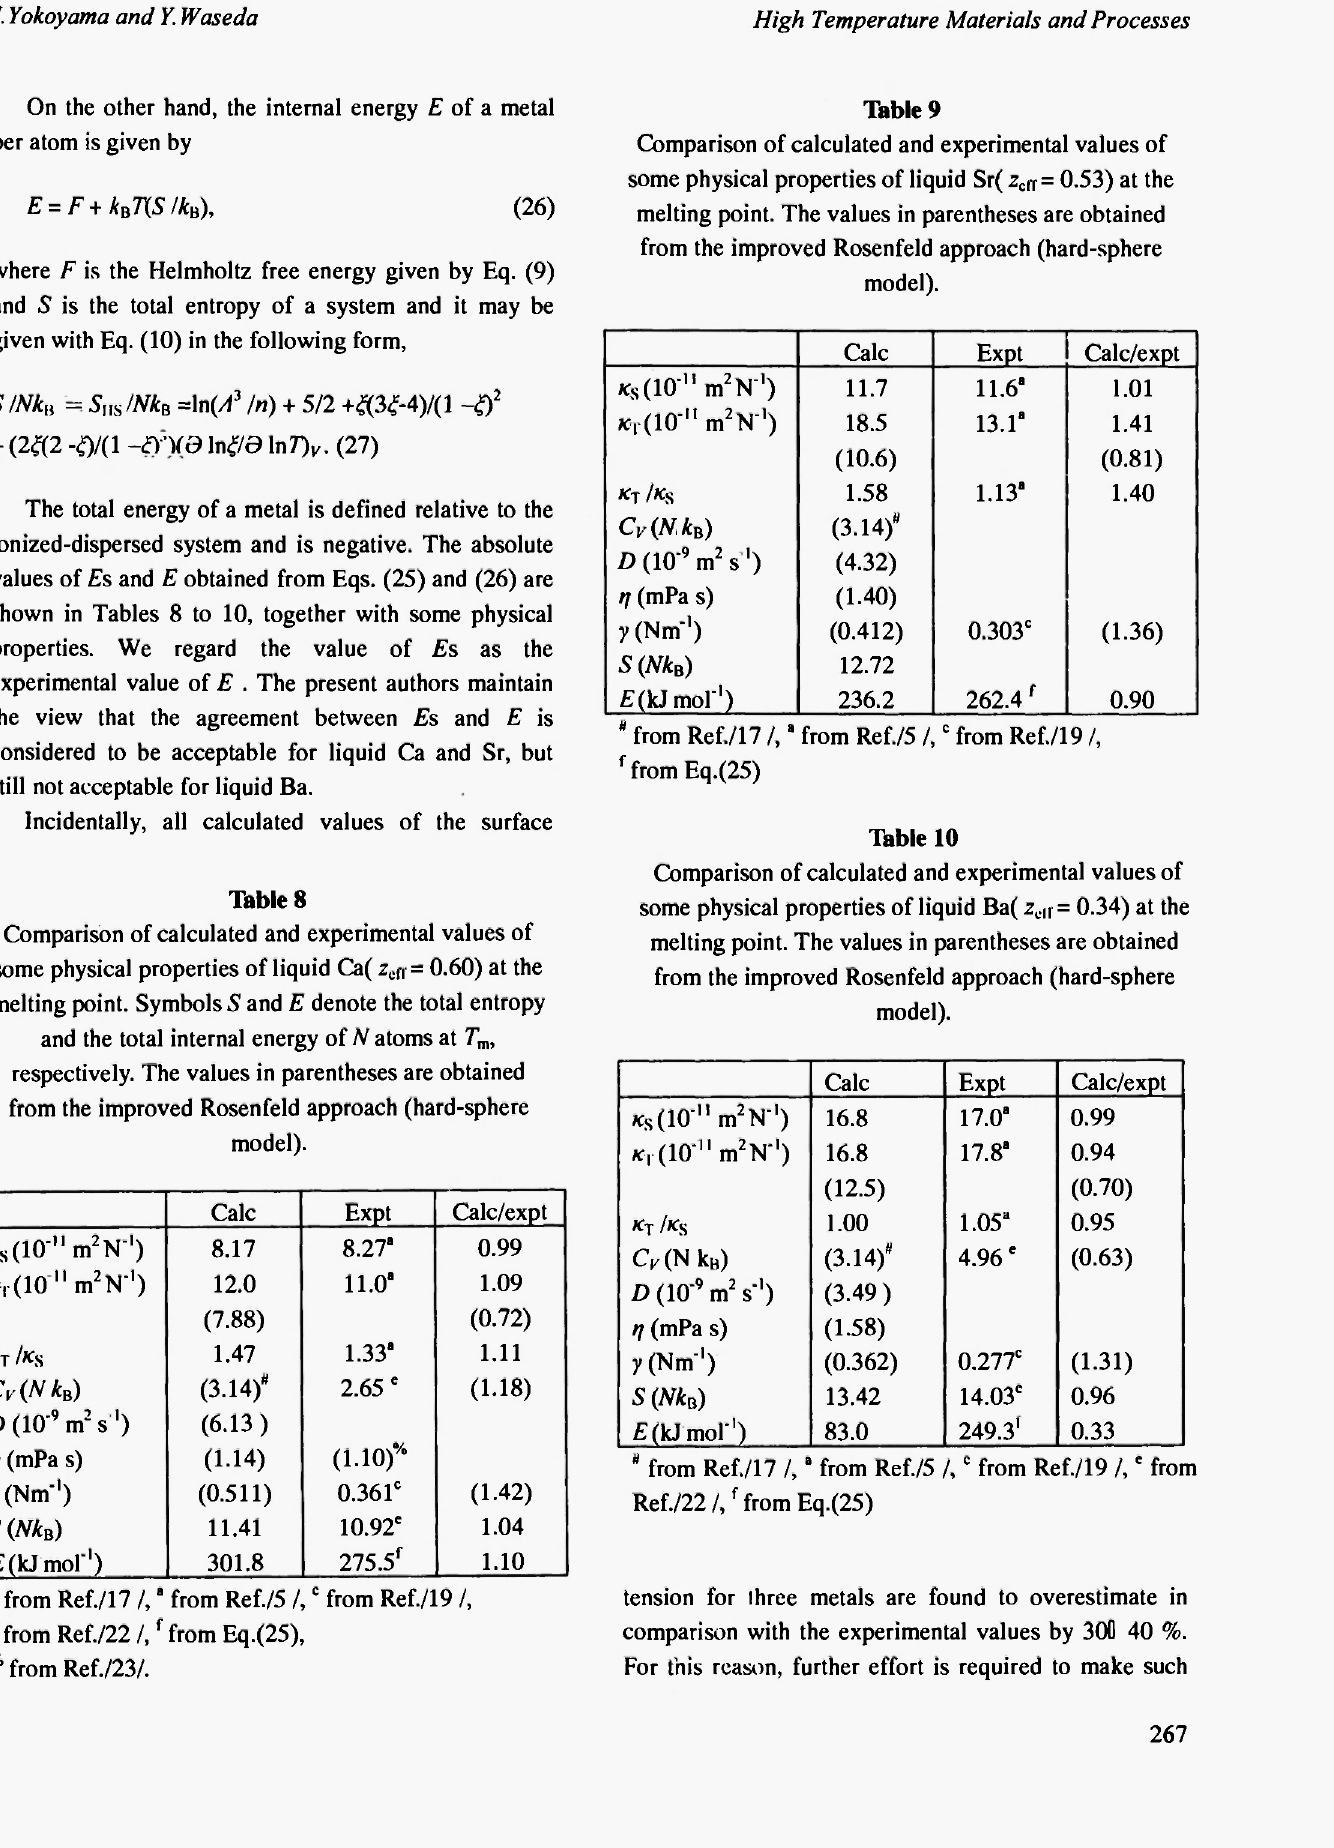
Comparison of calculated and experimental values of some physical properties of liquid Sr( z cIT = 0.53) at the melting point. The values in parentheses are obtained from the improved Rosenfeld approach (hard-sphere